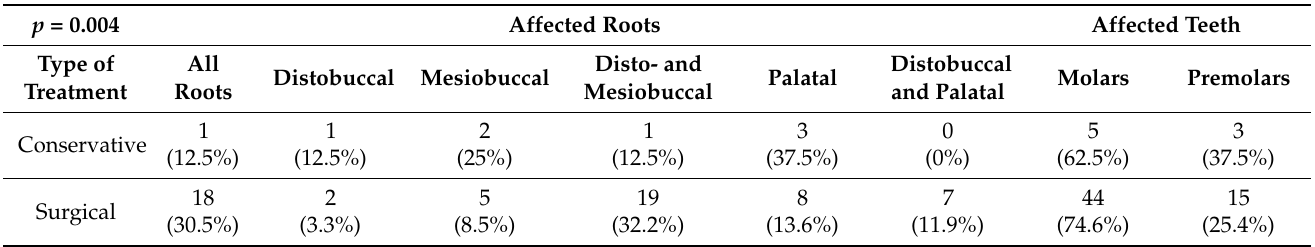
Table 3. Descriptive statistics (total number and percentage) of type of affected roots with periapical lesions in each of the subsequent treatment groups of patients; p = 0.004.